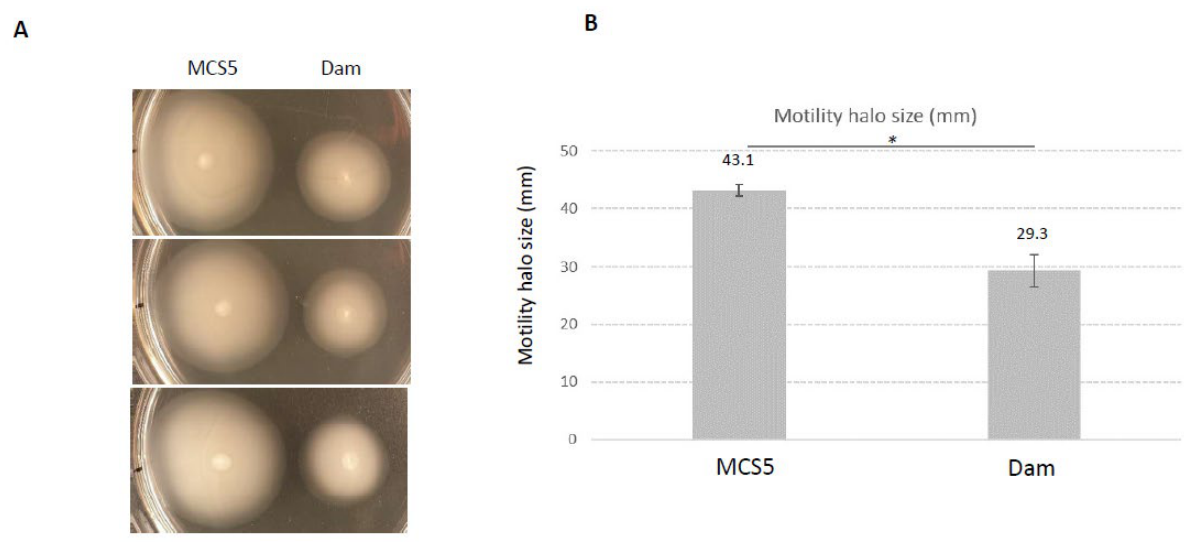
Figure 6. Swimming motility of X. nematophila F1 overexpressing dam gene (Dam) and control (MCS5). ( A ) Swimming halos were observed on low agar LB medium inoculated with 5 µ L of exponentially growing cells (3 independent biological replicates are shown). ( B ) Halo size of motility of each strain measured after 24 h of incubation. * Difference between the two strains is significant ( p < 0.05, Student’s t -test).